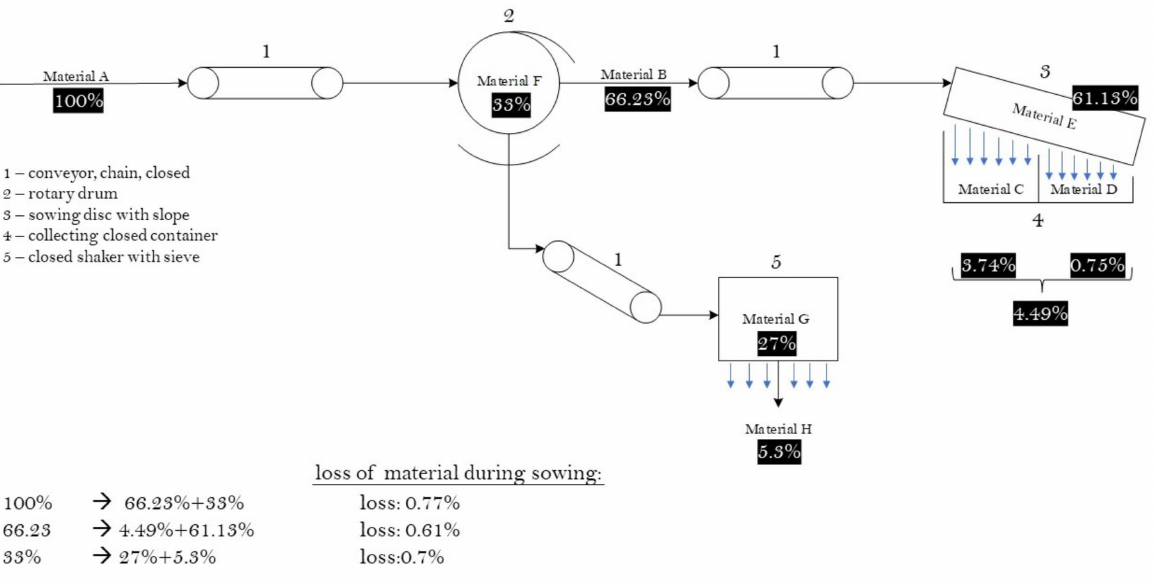
Figure 1. The process of sieving and separating parts of hemp. Material A: whole dried hemp; B: dried seedless and wasteless hemp; C: hemp powder - the first half of the sifted material in a sieve (3); D: hemp powder - the other half of the sifted material in a sieve (3); E: material residue on sieve (3); F: material remaining in the sieve (2); G: pure hemp seeds and H: waste material (mainly stems). Seven material samples (A, B, C, D, E, G, H) were obtained during sieving. Dried hemp (materials A, B, C, D, E, and H) was decarboxylated for 60 min at 140 ◦ C. Extraction was performed for materials A, B, C, D, E, and H. Material F was a collection of seeds and waste material, which was further sieved (5) and only then the resulting hemp seeds (material G) and waste material representing stems (material H) were extracted. Hemp seeds do not contain cannabinoids, but the extraction of this fraction has been performed for